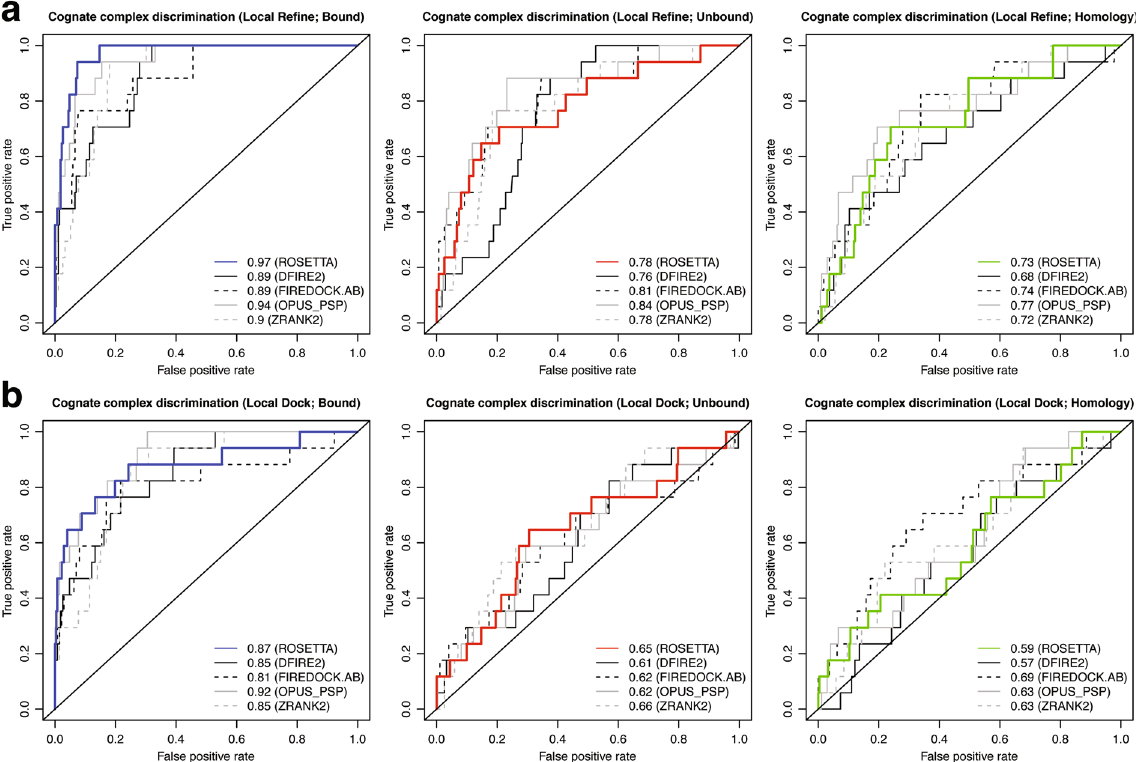
Figure 8. Receiver Operating Characteristic (ROC) curves for binder discrimination. ROC curves using Rosetta interface score of the top-scoring model as the classifier for ( a ) local refine, and ( b ) local dock. The native cognate antibody – antigen interaction pairs are true positives. ROC curves computed using four additional potentials: DFIRE2, FIREDOCK.AB, OPUS_PSP, and ZRANK2 are shown for comparison. The bottom right corner of the plot shows the area under the curve (AUC) for Rosetta bound (blue), unbound (red), and homology (green) complexes compared to the other